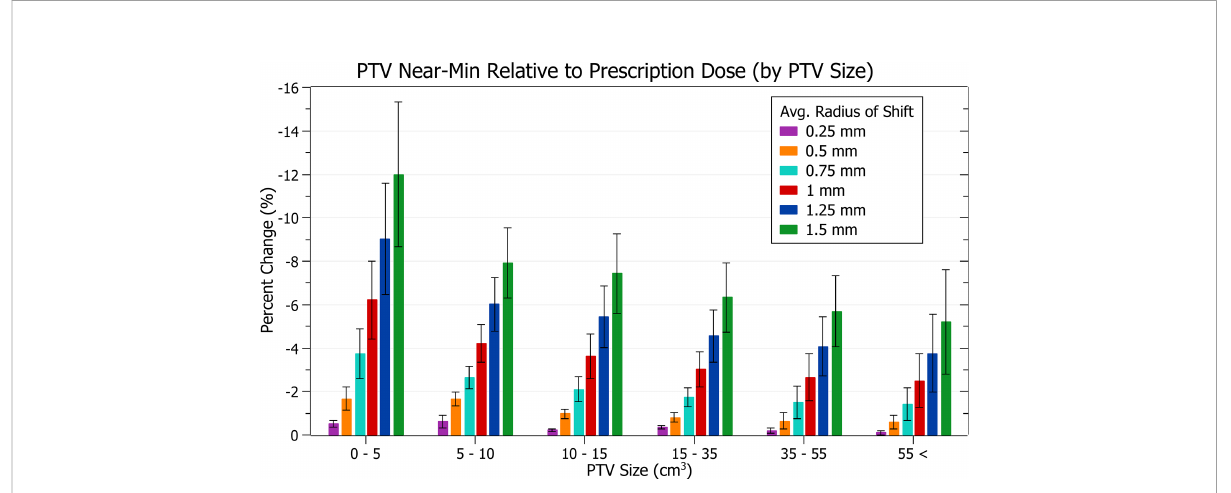
FIGURE 7 Average percentage change of PTV near-min relative to prescription dose for different radii of isocentre shift, categorised by PTV